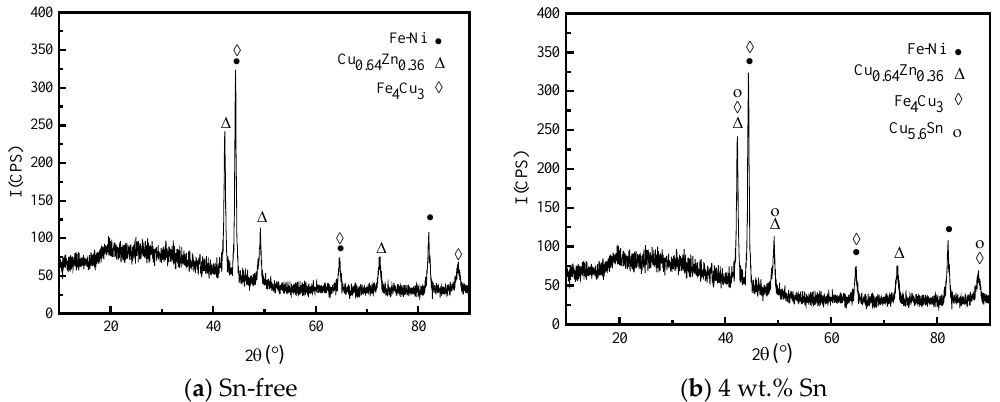
Figure 5. XRD analysis results of the matrix phase of samples with different Sn contents.